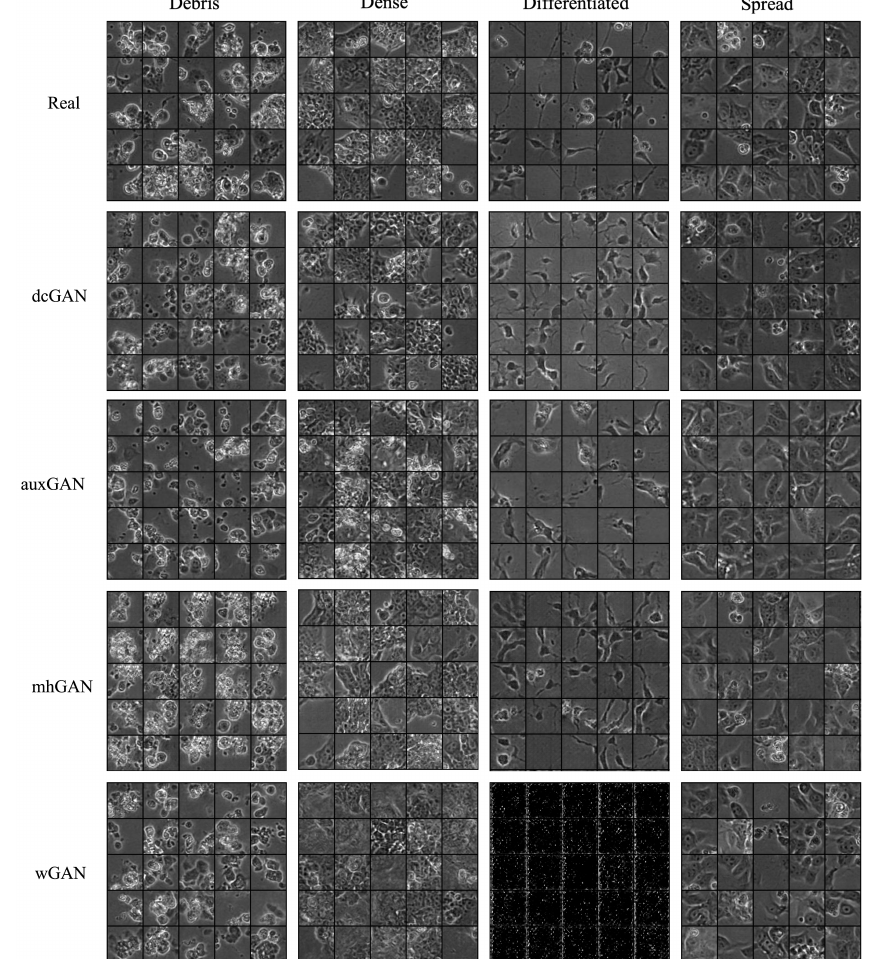
Figure 6. Image patch samples for real and generated images. A comparison of classwise image features displays generally realistic image features indicative of morphological class. However, visual appearance of images provides only a qualitative measure of image quality, where quantitative metrics are necessary to determine image